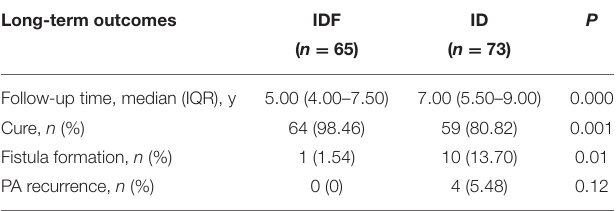
TABLE 2 | Long-term outcomes of IDF vs.